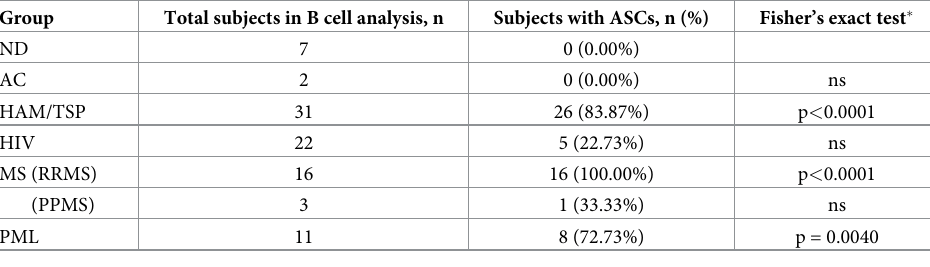
Table 2. Detection of antibody secreting B cells in CSF.